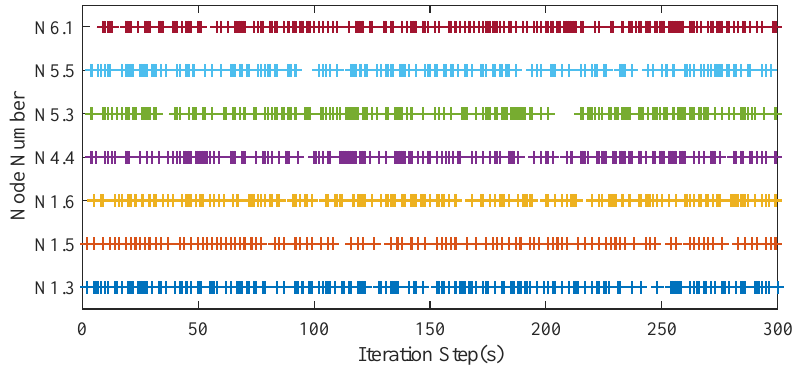
Figure 4. Time evolution of event-triggered